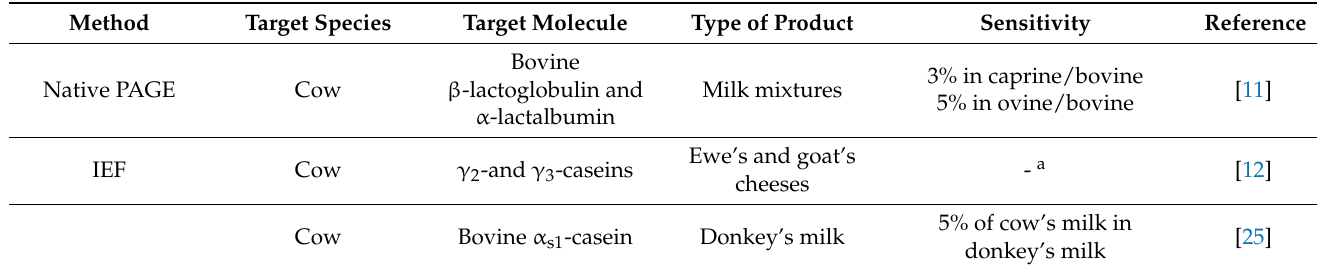
Table 1. Summarized information of examples on reported electrophoretic and immunochemical methods applied to species identification in dairy